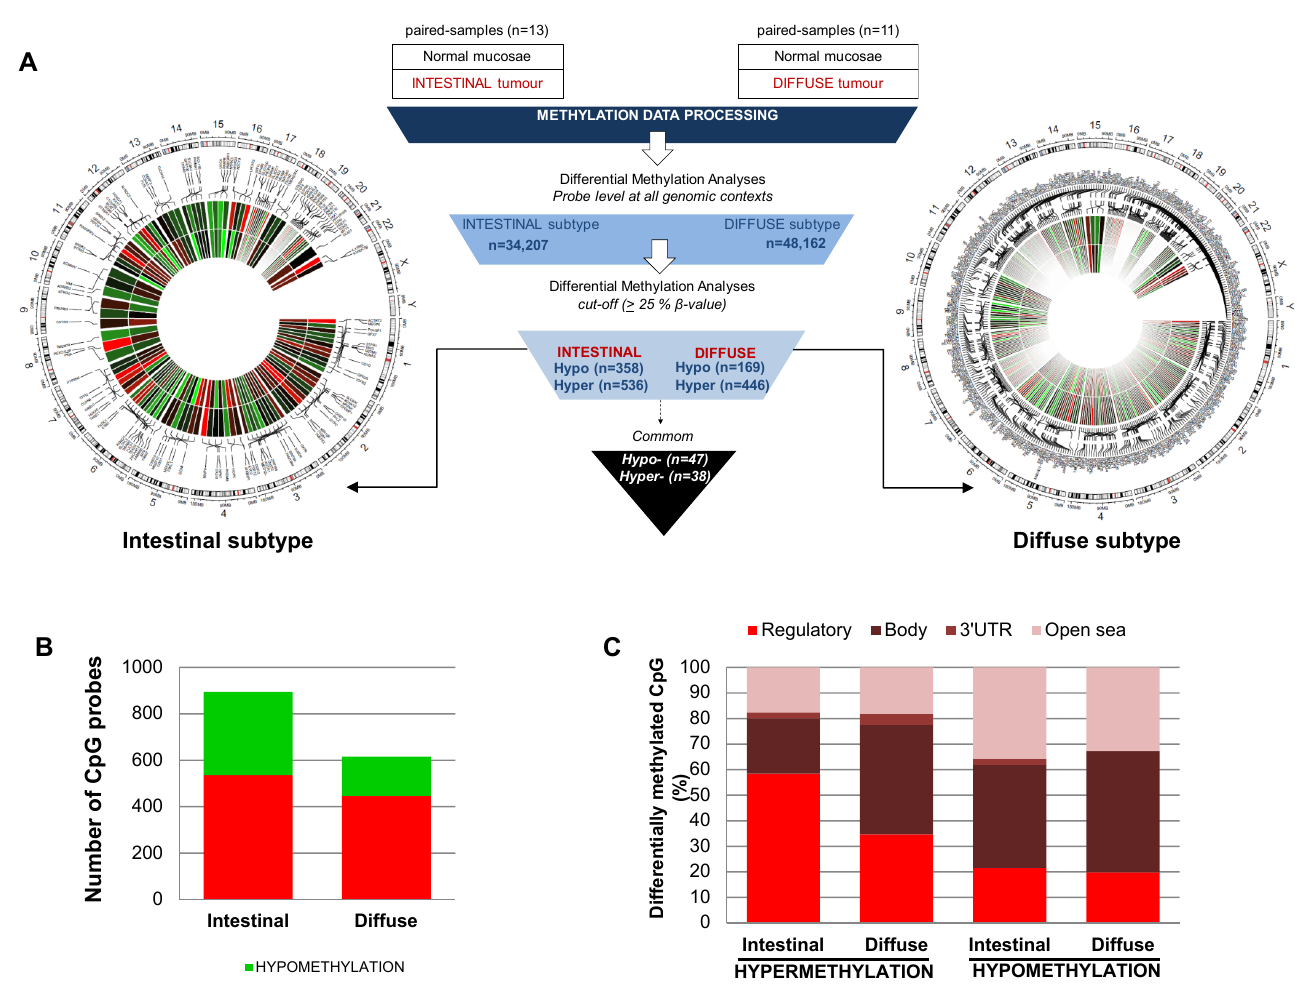
Figure 1. CpG methylation signature of intestinal and diffuse types of gastric cancer. ( A ) Center, workflow of the cancer- related study. Circus graphs for genome-wide DNA methylation levels in diffuse (right) and intestinal (left) gastric tumors. The inner track indicates the β -value of the non-tumoral and the outer circle represents the cancer sample. ( B ) Total number of hypermethylation and hypomethylation events in gastric cancer, relative to adjacent non-tumoral samples. ( C ) Genomic distribution of differentially methylated CpGs in the intestinal and diffuse types of gastric